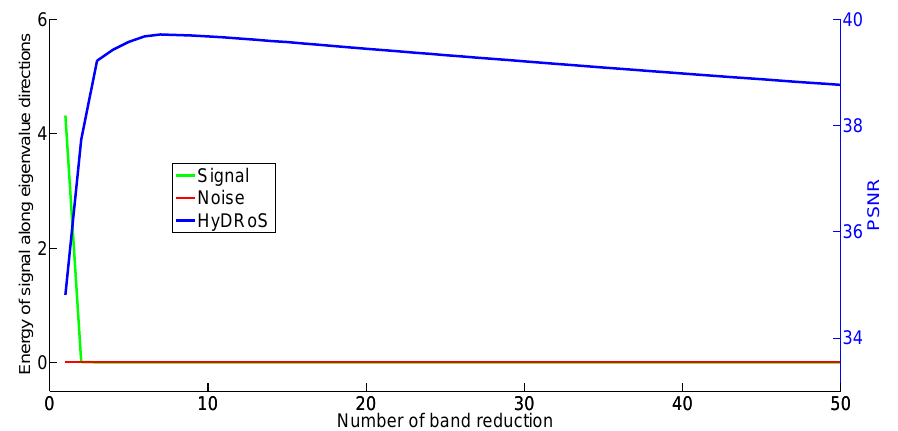
Figure 6. Power of the signal (green) and of the noise (red) and performance of HyDRoS as a function of the subspace dimension.